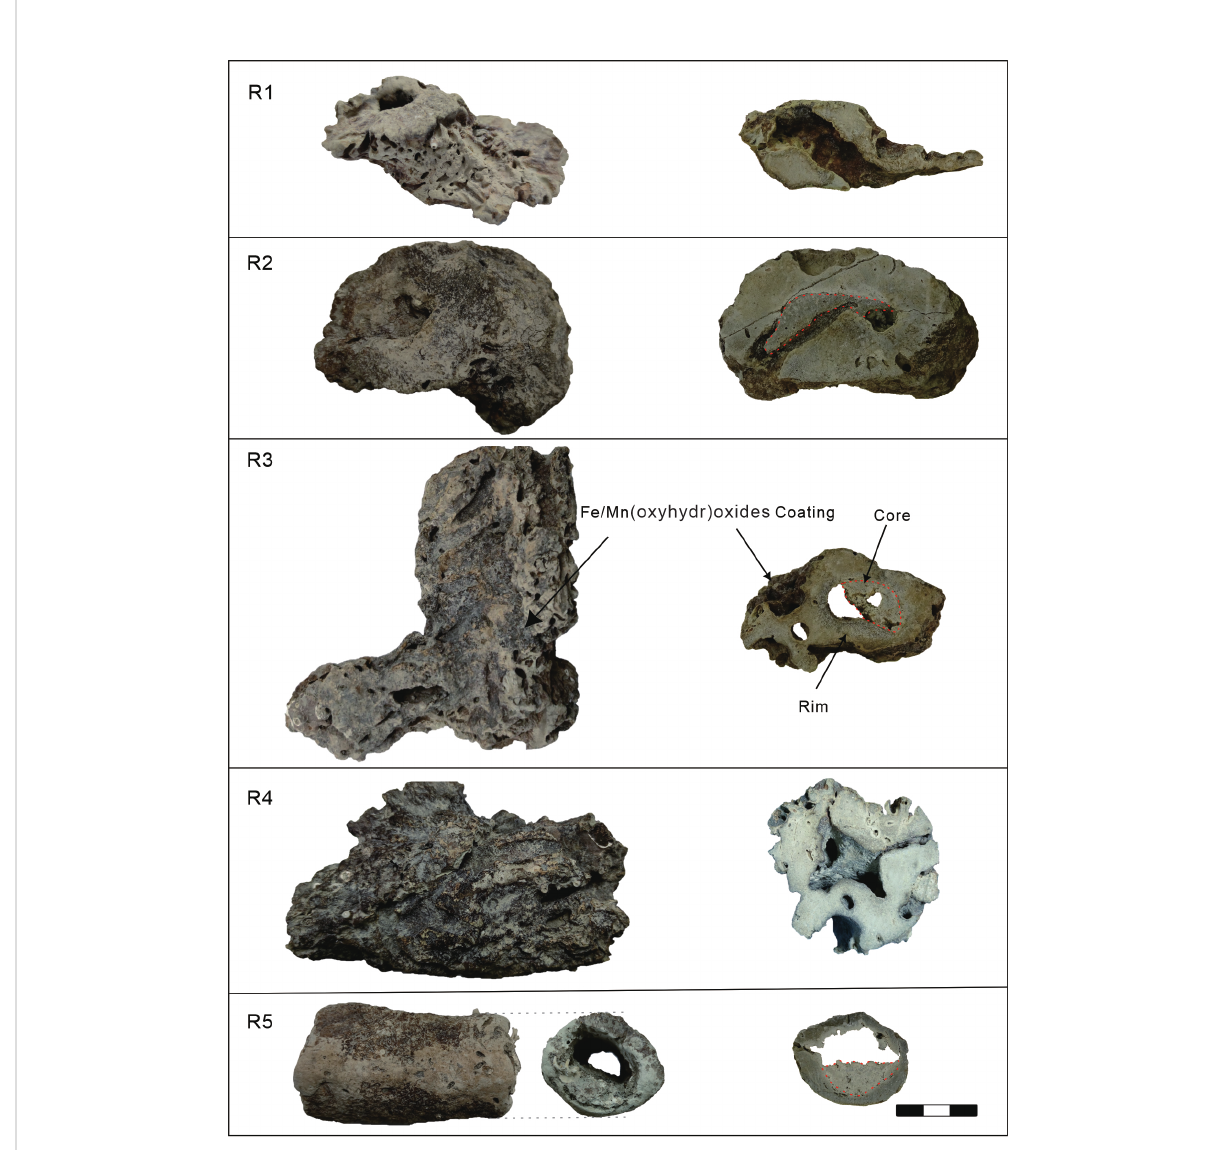
FIGURE 1 Morphologies of the selected tubular carbonates (left) and their fresh-cut surface (right) in this study. The cores were circled by red dashed lines. The scale bar is 3